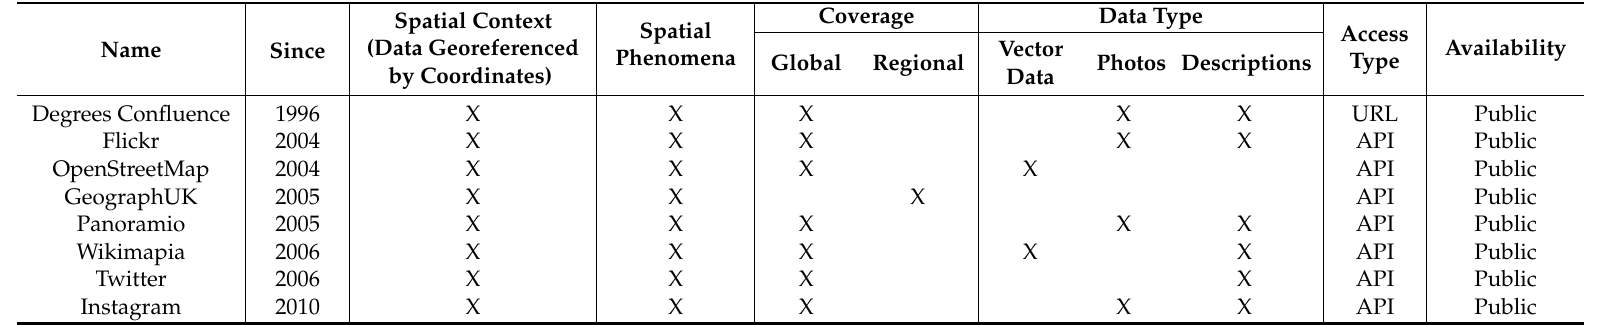
Table 2. Selected User Generated spatial Content (UGsC)